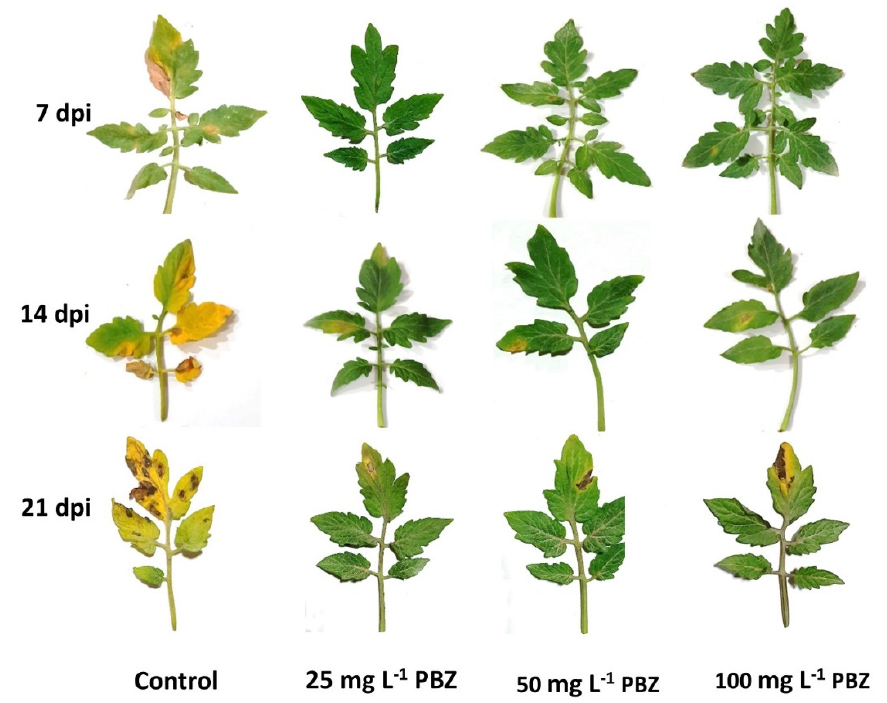
Figure 2. Effect of Paclobutrazol (PBZ) on progress symptoms of early blight disease on tomato seedlings under greenhouse conditions at 7, 14, and 21 dpi (day post inoculation).